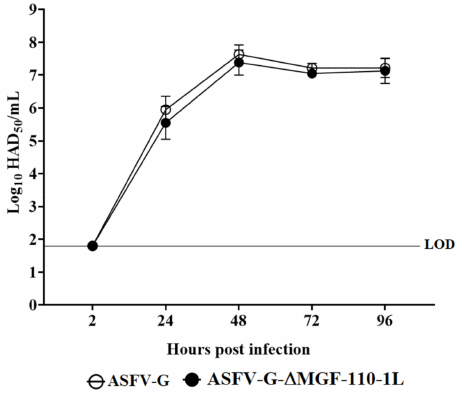
Figure 4. In vitro growth kinetics in primary swine macrophage cell cultures for ASFV-G- ∆ MGF110- 1L and parental ASFV-G, infected (MOI = 0.01) with ASFV-G- ∆ MGF110-1L or parental ASFV-G viruses. Samples were taken from three independent experiments at the indicated time points and titrated. Data represent means and standard deviations. Sensitivity using this methodology for detecting virus is >log10 1.8 HAD 50 /mL. No significant differences in viral yields between viruses were observed at any time point tested determined using the Holm-Sidak method ( α = 0.05), without assuming a consistent standard deviation. All calculations were conducted using the software Graphpad Prism version 8.